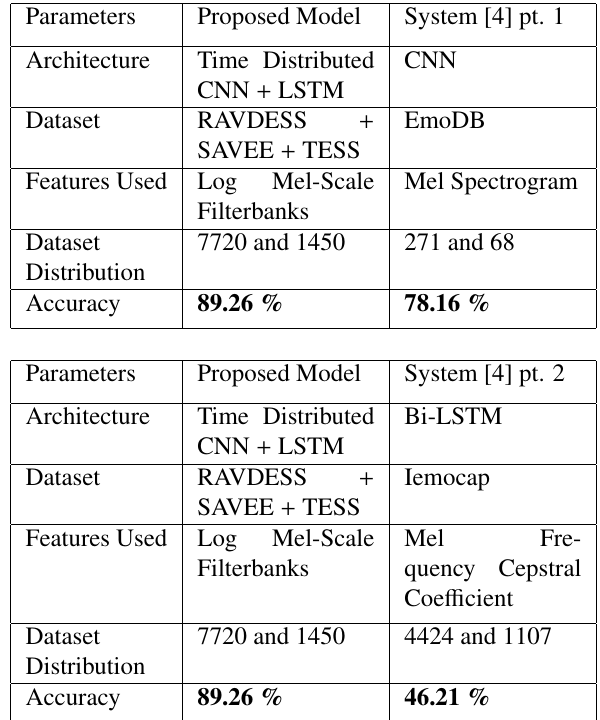
Table 3. Comparison with Existing System